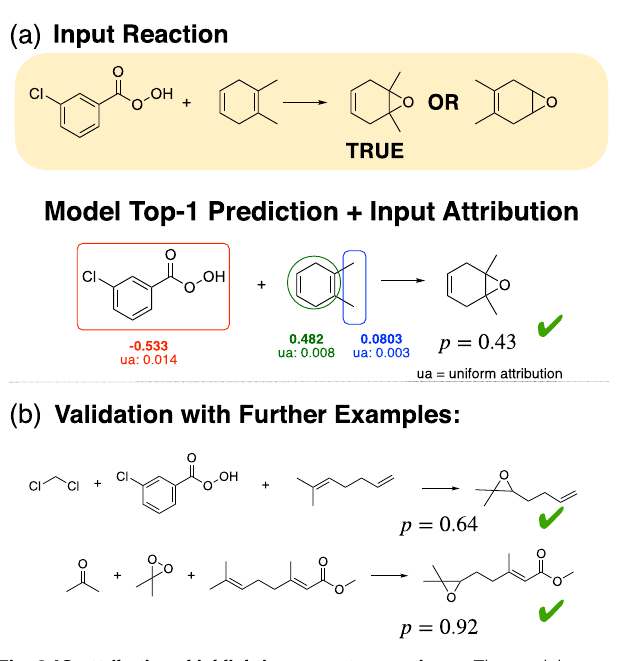
Fig. 2 IG attributions highlighting correct reasoning. a The model correctly predicts the product of a typical epoxidation reaction, and shows signi fi cant positive attributions to the two methyl group that are responsible for the selectivity. b We validate the model ’ s knowledge on two unseen epoxidation reactions from chemical literature 39